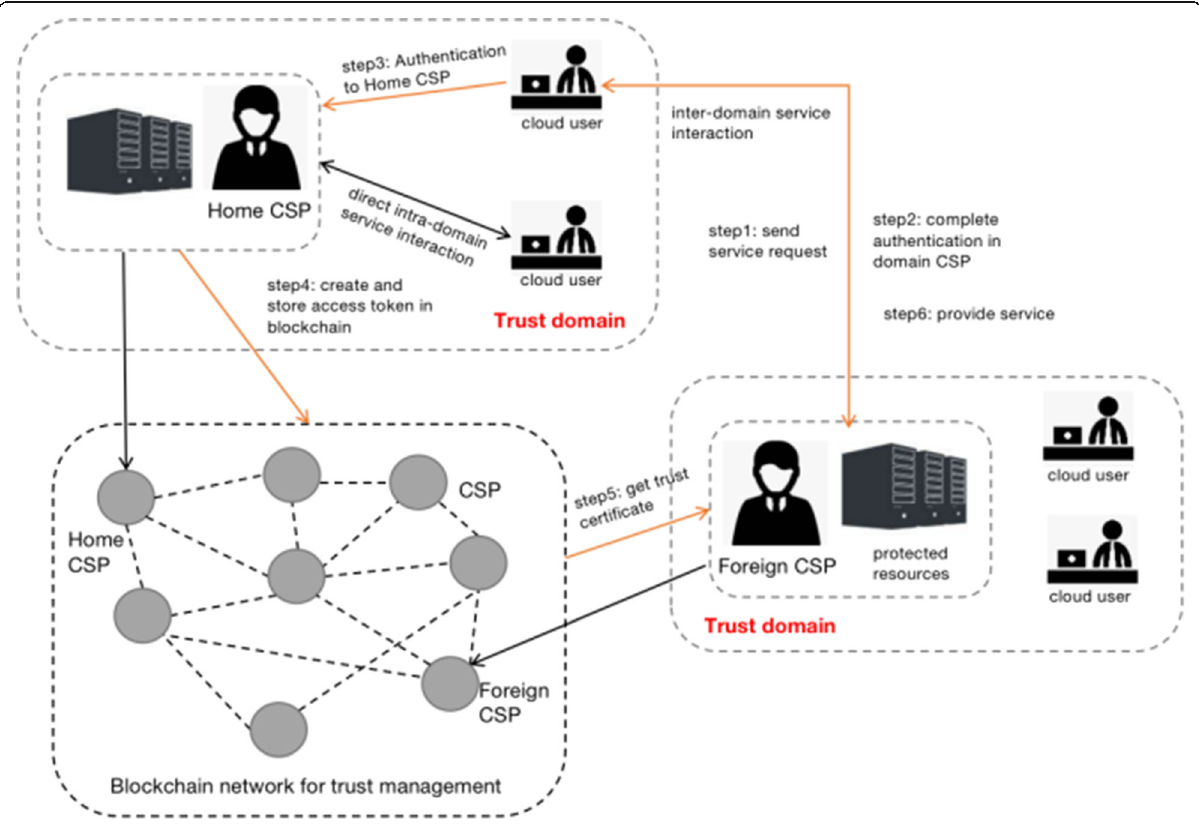
Fig. 3 Blockchain acts as an identity authentication platform